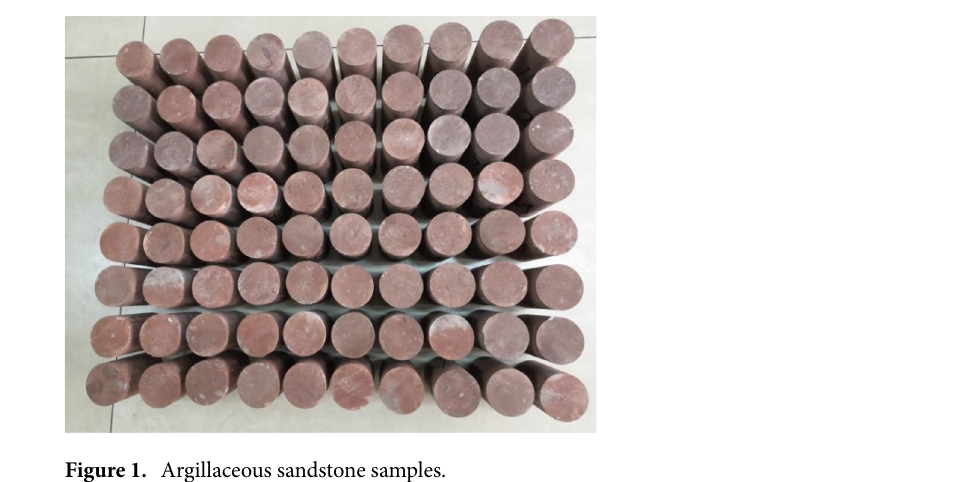
Figure 1. Argillaceous sandstone